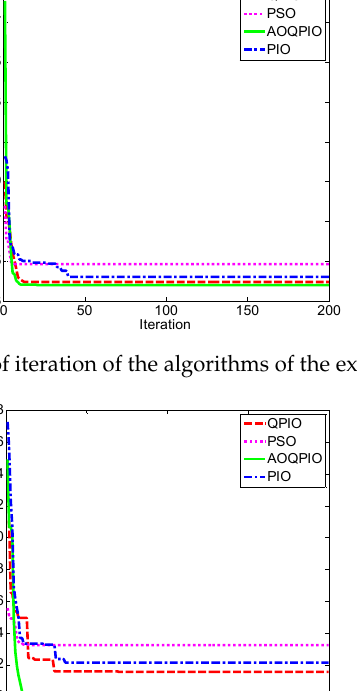
Algorithms 2019 , 12 , 3 Figure 5. ( a ) is the result of the experiment and ( b ) is the result of optimal UAV altitude of the experiment carried out in map 3.